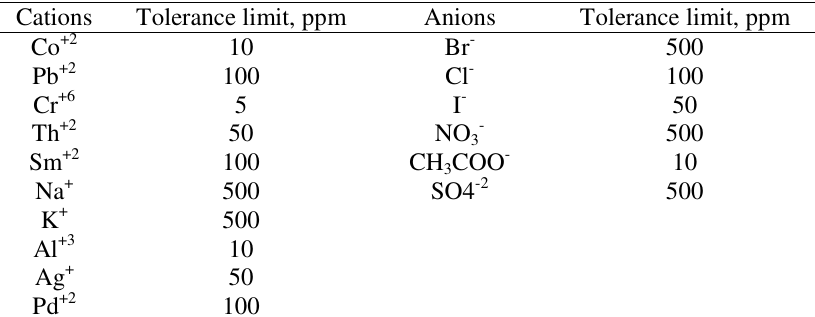
Table 2. Interference of diverse ions.